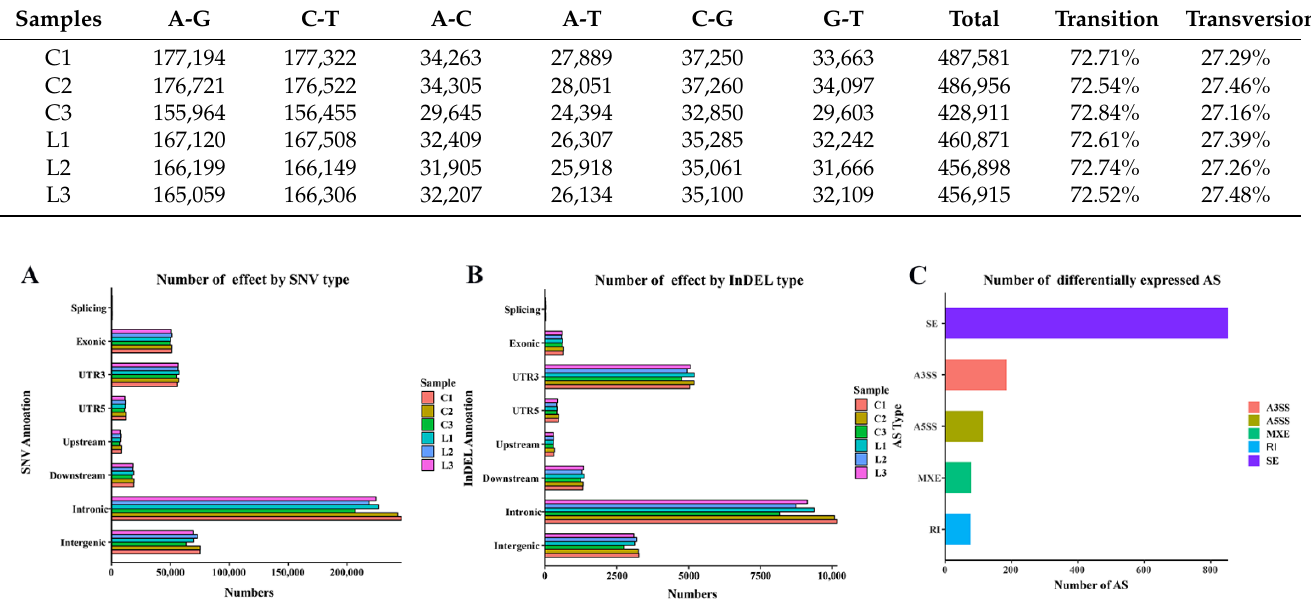
Figure 3. Annotation and classification of SNV/InDel and the prediction of alternative splicing. ( A ) The number of effects by SNV stype, ( B ) The number of effects by INDEL type. ( C ) The number of differentially expressed AS. SE stands for skipped exon, A3SS stands for alternative 3 (cid:48) splice site, A5SS stands for alternative 5 (cid:48) splice site, MXE stands for mutually exclusive exons, RI stands